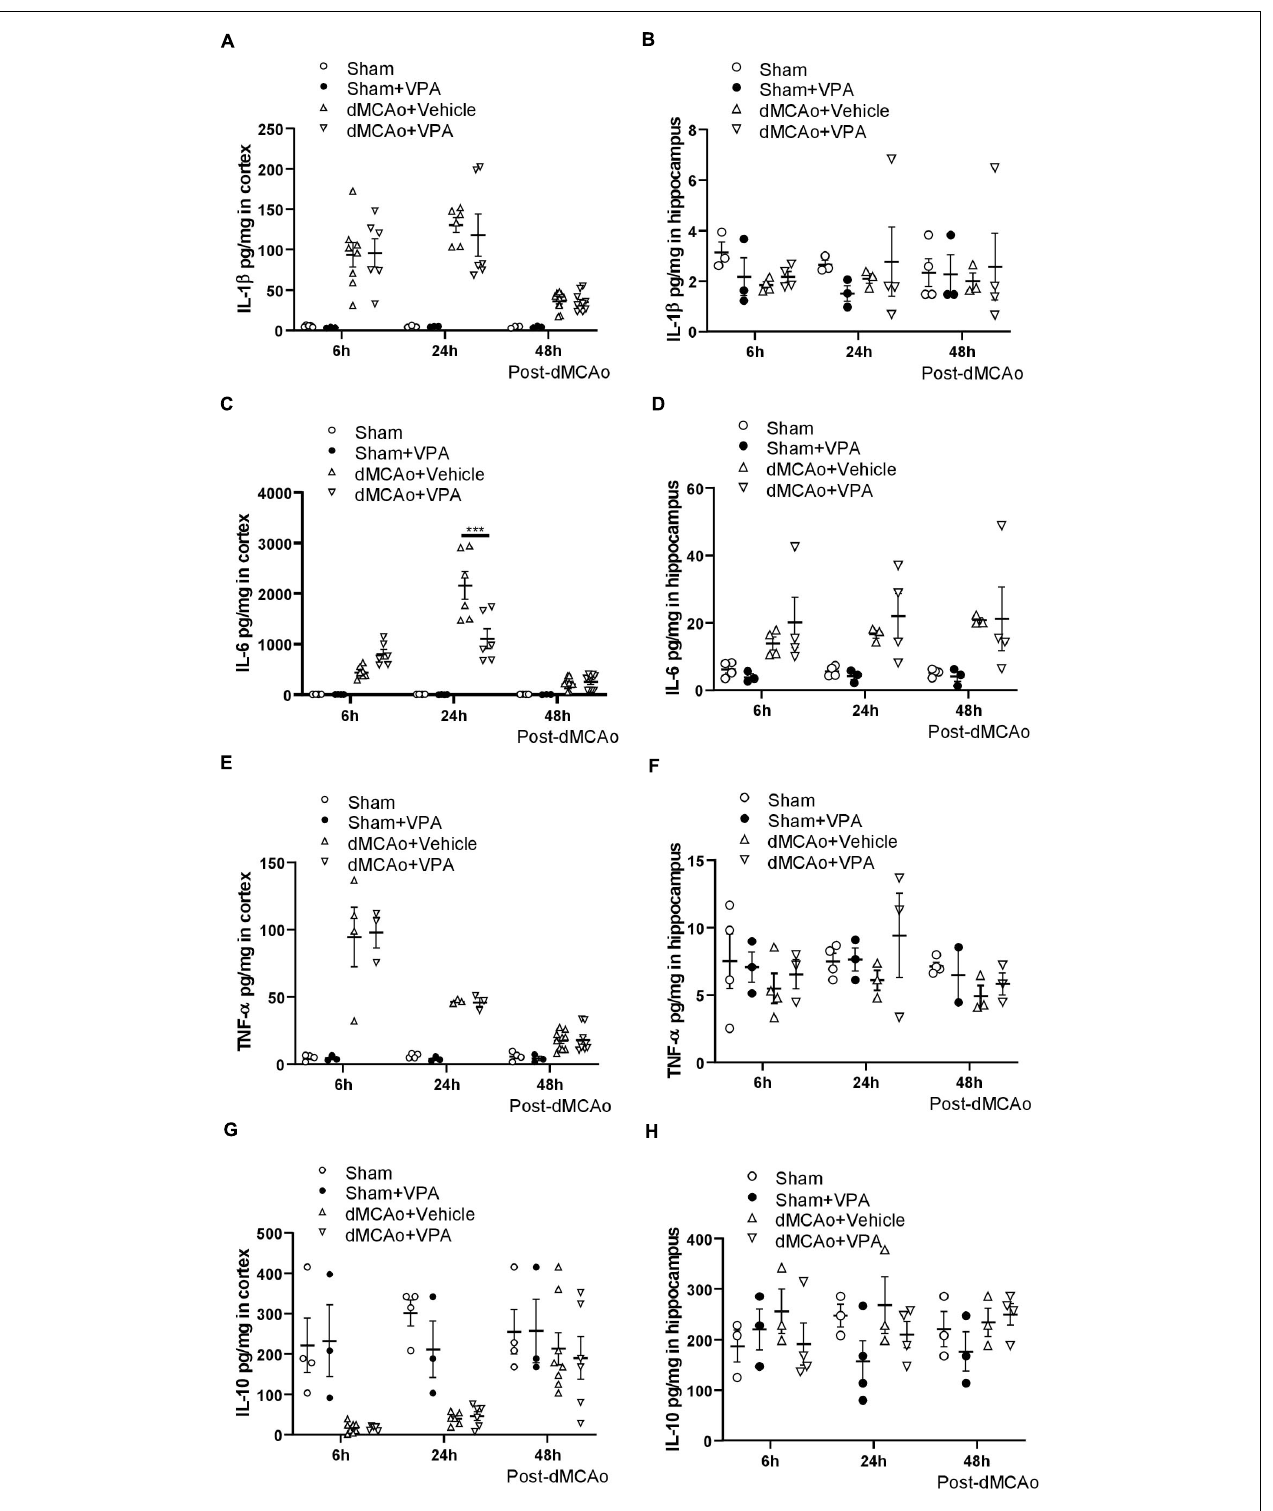
FIGURE 2 | Valproic acid suppresses IL-6 production in the peri-infarct cortex at 24 h after dMCAo surgery. (A,B) IL-1 β concentrations in the peri-infarct cortex (A) and ipsilateral hippocampus (B) were measured by ELISA. (C,D) TNF- α concentrations in the peri-infarct cortex (C) and ipsilateral hippocampus (D) were measured by ELISA. (E,F) IL-6 concentrations in the peri-infarct cortex (E) and ipsilateral hippocampus (F) were measured by ELISA. (G,H) IL-10 concentrations in the peri-infarct cortex (G) and ipsilateral hippocampus (H) were measured by ELISA. *** p < 0.001 indicates comparison with the dMCAo + vehicle group with two-way ANOVA, Bonferroni’s post hoc test. The data represent mean ±